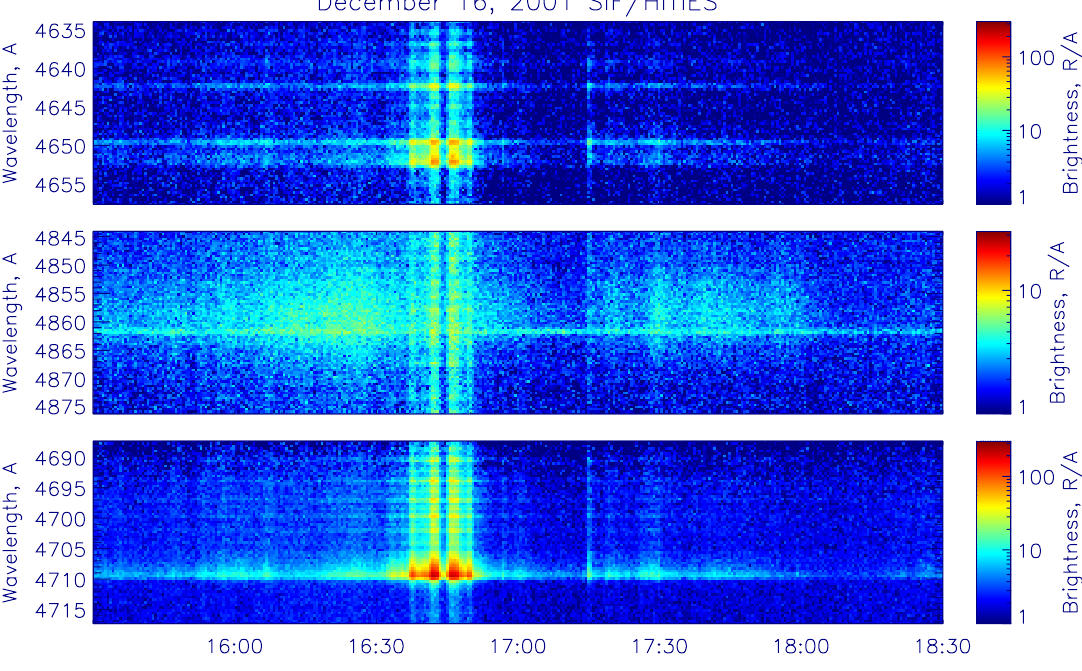
Fig. 2. Overview plot of the SIF data from 15:30–18:30 UT, 16 December 2001. The panels show the time dependence of the spectra of the N + 1N(1,3) band, H β , and the N + 1N(0,2) band, respectively, as measured by HiTIES. 2 2 N + 1N(1,3) emission with the head at 4651.8 ˚A and another 2 O + line at 4650.8 ˚A. Even fainter is the O + line at 4638.9